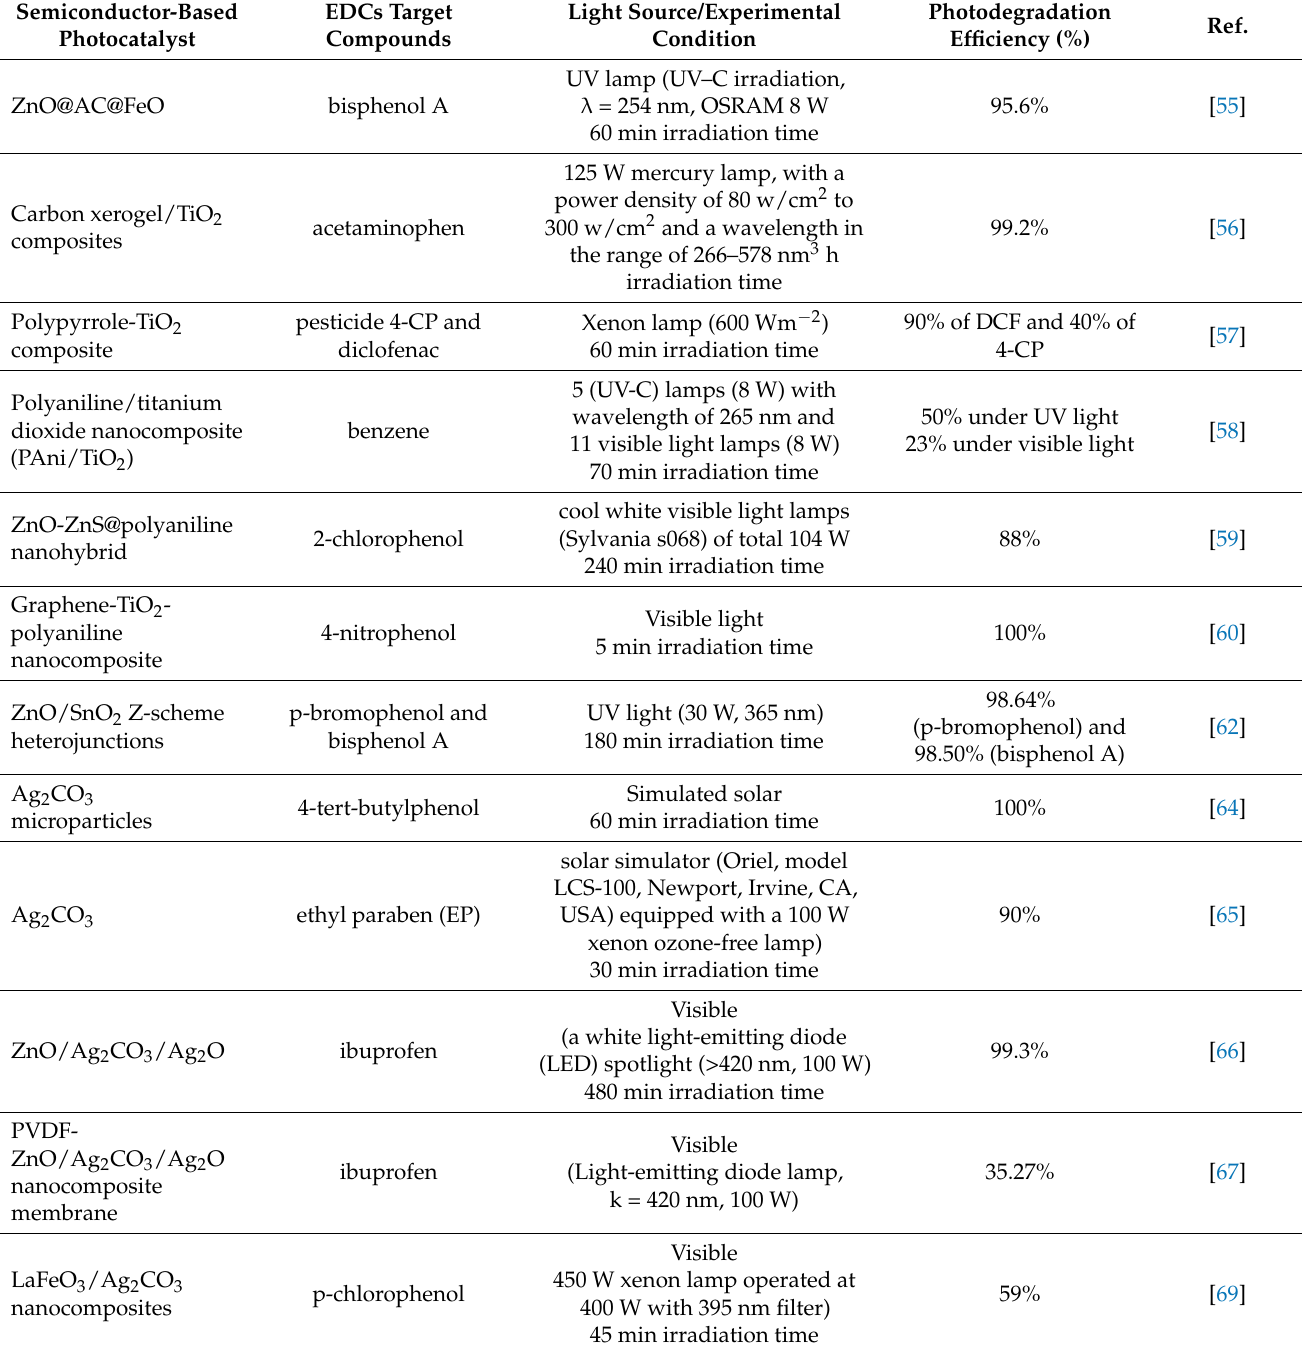
Table 2. Photocatalytic degradation of EDCs of over-selected semiconductor-based materials from aqueous